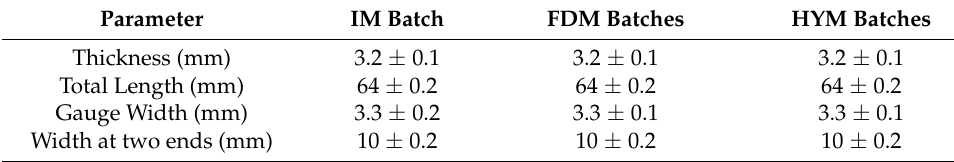
Table 4. Parameters of sections for all